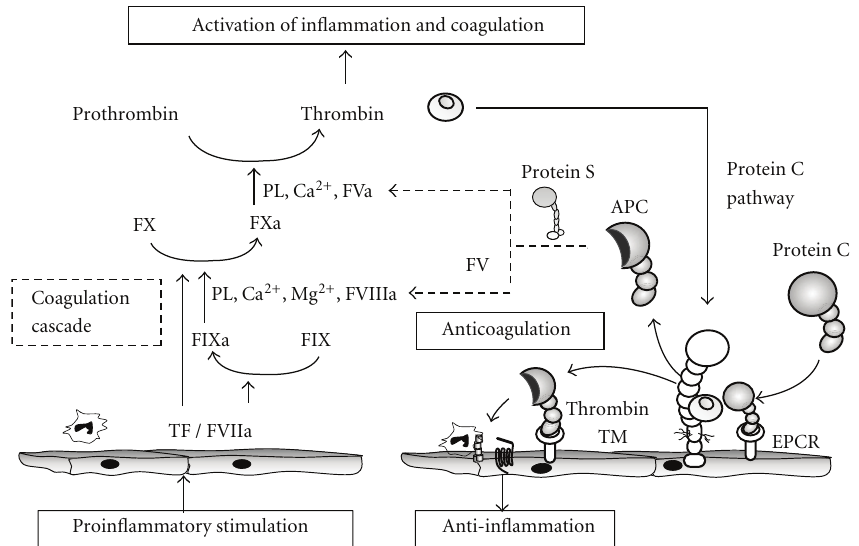
Figure 1: Crosstalk between inflammation and coagulation. Proinflammatory stimulation induces TF expression in monocytes, macrophages, and endothelial cells. TF initiates a coagulation cascade and the FXa-FVa complex converts thrombin. Thrombin induces fibrin formation and activates platelets, monocytes, and endothelial cells through PARs. Thus, thrombin acts to form a positive feedback loop that augments coagulation and inflammation. In a negative feedback loop, the thrombin-TM complex activates protein C and downregulates coagulation and inflammation. APC, in tandem with its cofactor protein S, inactivates FVa and FVIIIa. In addition, the APC-EPCR complex induces anti-inflammatory e ff ects through PARs. Therefore, thrombin, TM, and protein C-EPCR play pivotal roles in the crosstalk that occurs between inflammation and coagulation.